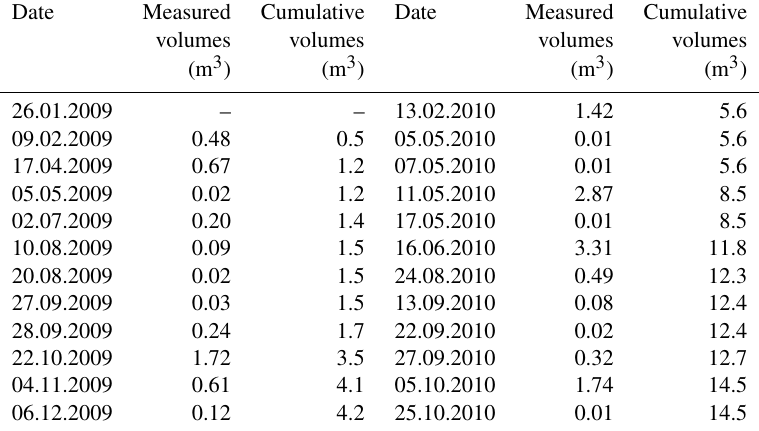
Table 3. Measured volume in the sediment